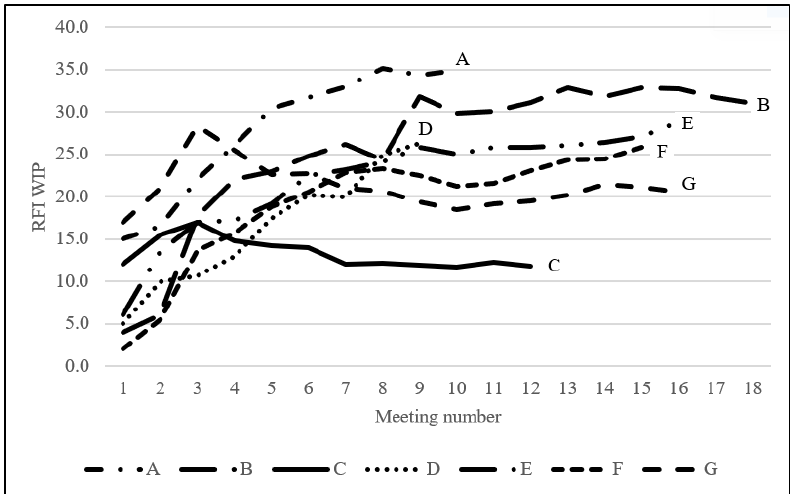
Figure 3. Response time of RFIs—drawing review.